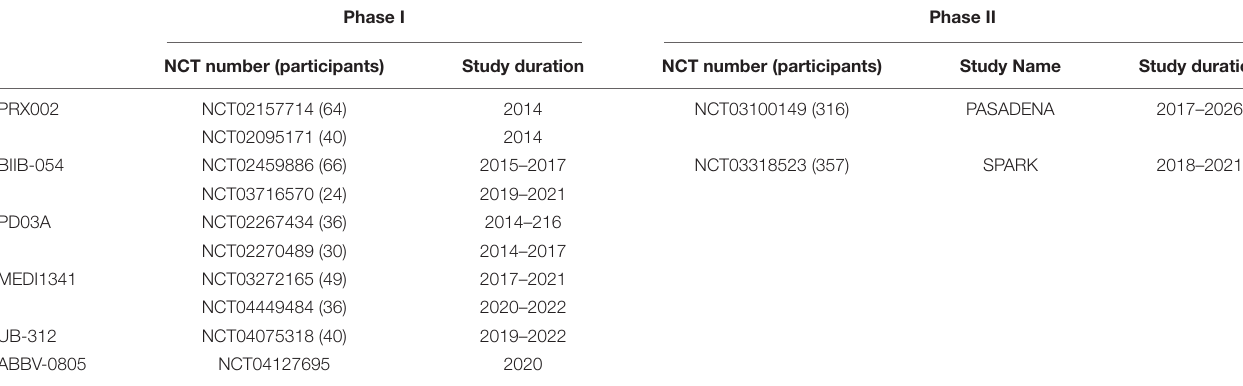
TABLE 3 | Summary of Clinical trials for passive and active immunotherapy in Parkinson’s disease. Phase